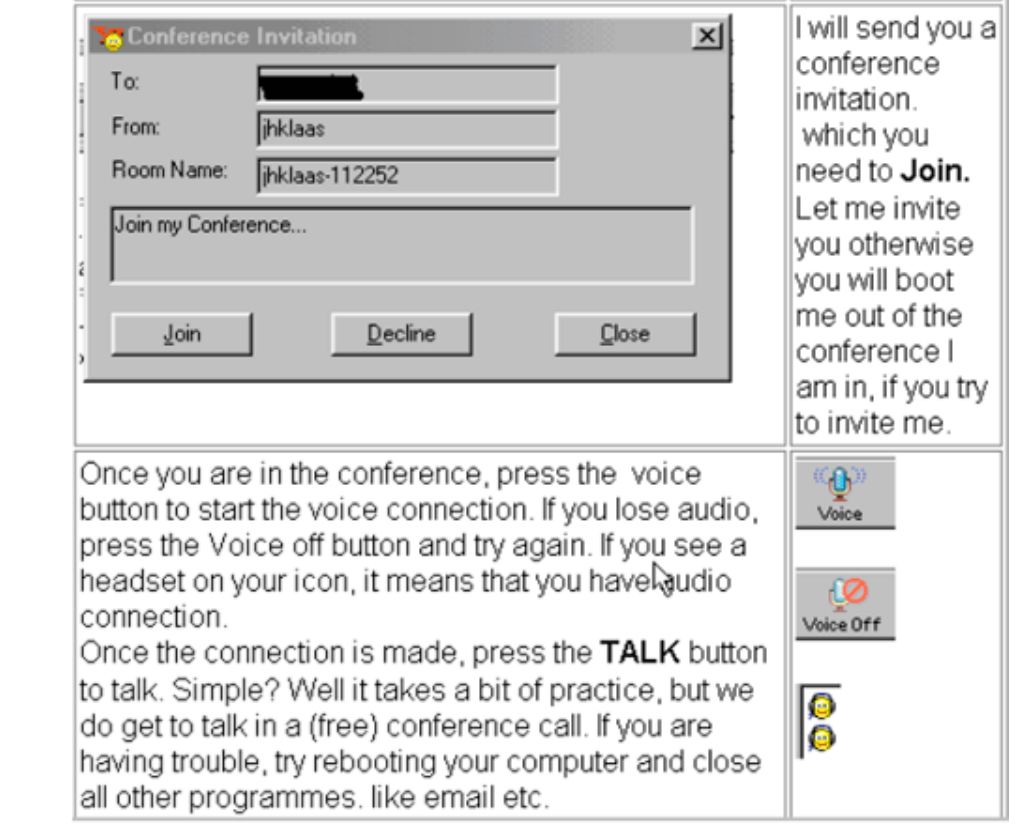
Figure 1. Sample online instructions for conference